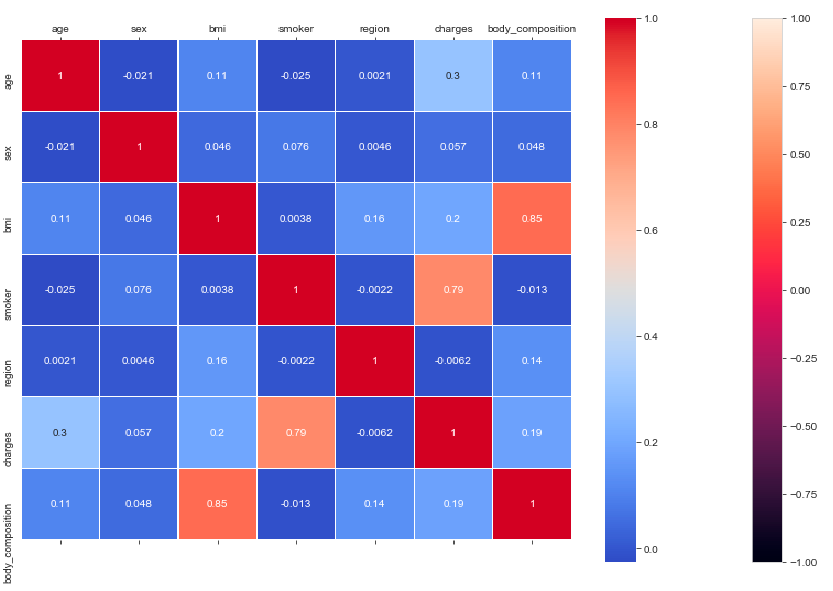
Figure 6. Correlation heatmap and classification accuracy of ML models to classify “Insurance” data.